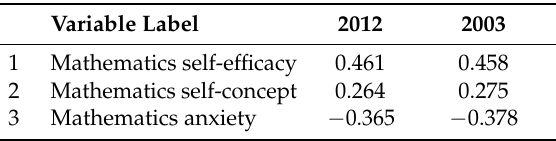
Table 2. The correlations between the PISA Mathematics Achievement Scores and Self-beliefs (N = 485,490 for PISA 2012; N = 276,165 for PISA 2003) 1